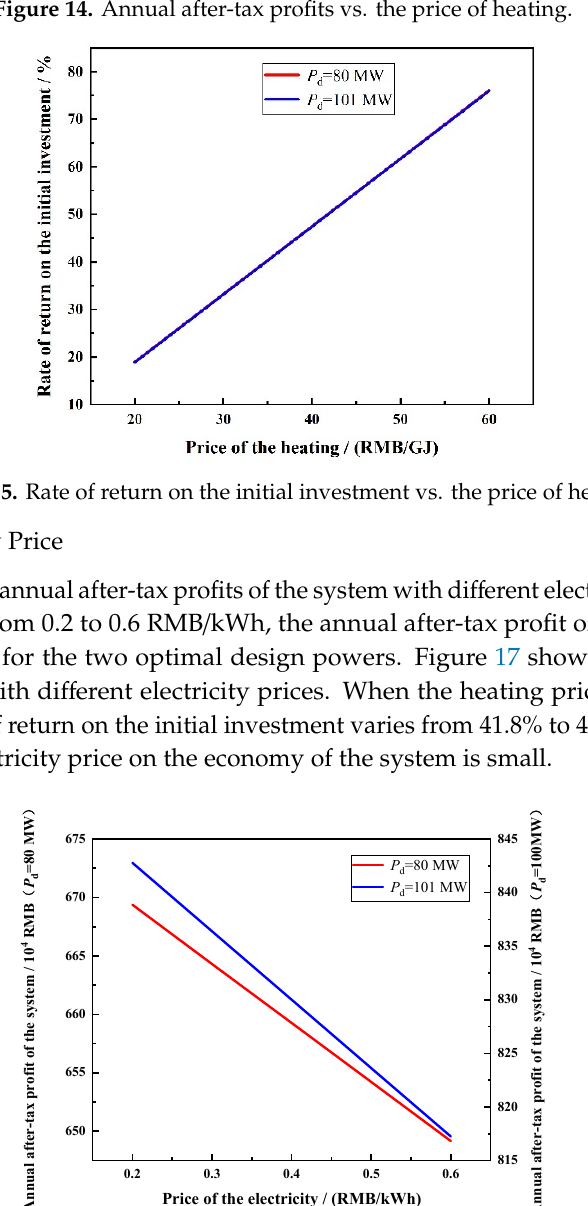
Figure 17. Rate of return on the initial investment vs. the price of the electricity. 5. Conclusions On the basis of heating load characteristics, the design idea of a waste heat recovery system with a heat pump was presented in this paper. In order to satisfy the heating demand of different temperature levels, two connection types of heating supply systems were proposed. According to the relationship between the heating network load and the design power of the heat pump, four operating modes of the heat pump were discussed. An economic analysis model of the waste heat recovery system was proposed to optimize the design power of the heat pump. Finally, a detailed quantitative economic analysis of the waste heat recovery system is carried out with a typical unit. The main conclusions are summarized as follows: